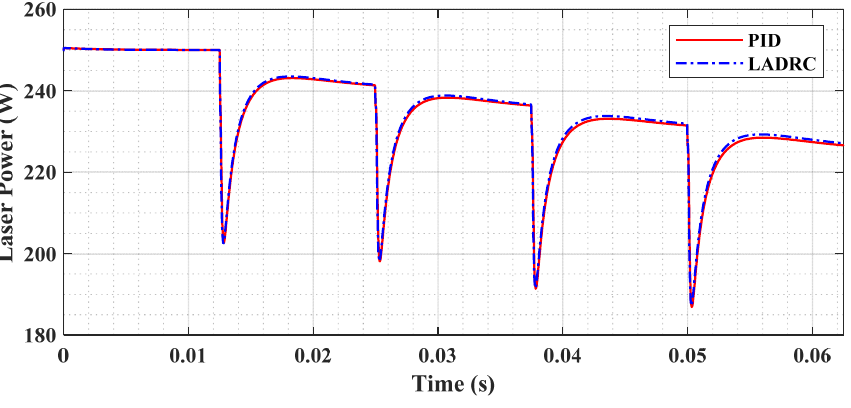
Figure 9. Input laser power in PID and ADRC.